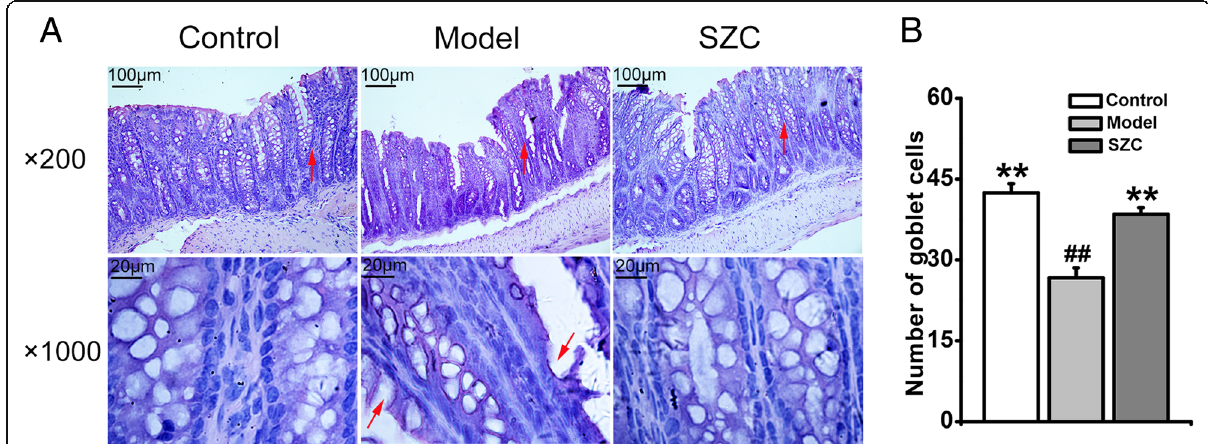
Fig. 3 The effects of SZC on histological changes of colon sections in mice with CID (n = 8, male/femal = 4). ( a ) Representative images of HE- stained colonic sections (200 × and 1000 × magnifications). ( b ) Number of goblet cells in HE-stained colonic sections (1000 × magnification). Red arrows in colonic sections (200 × magnification) indicated amplified target areas of pictures, and red arrows in colonic sections (1000 × magnification) indicated damaged goblet cells. Data were presented as means ± SEM. * P < 0.05 and ** P < 0.01 compared with model, # P < 0.05 and ## P < 0.01 compared with